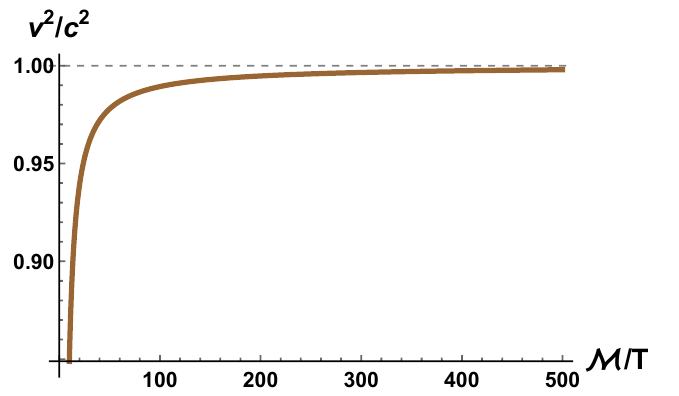
Figure 4 . The shear modes speed (3.10) normalized to the relativistic speed c = 1 in function of the cuto(cid:11) M =T